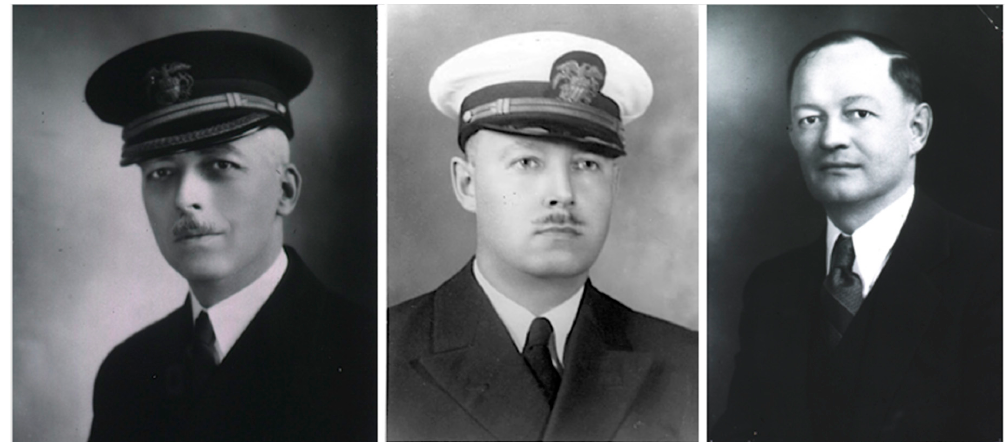
Figure 2. Typhus triumvirate of the United States Public Health Service: ( left) Eugene Rollo Dyer; ( center ) Adolph Rumreich; ( right ) Lucius Badger. Along with William Workman and Elmer Ceder, these men determined that FBT has a domestic rodent reservoir and is transmitted by the flea feces and discovered the vector potential of the Oriental rat flea. In 1931, the team also di ff erentiated FBT from Rocky Mountain spotted fever (RMSF). For his work on typhus, Dyer was awarded the